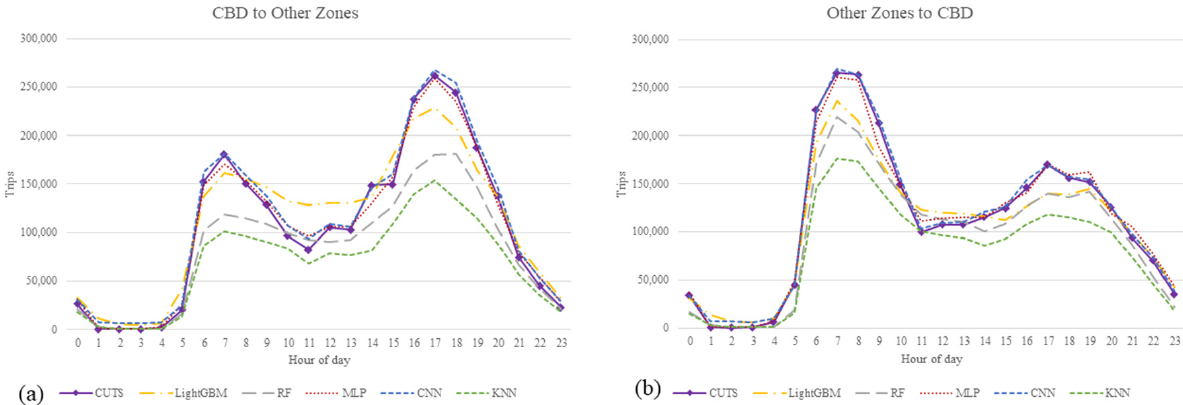
distribution of trips from CBD to other zones, ( b ) temporal distribution of trips from other zones to CBD.